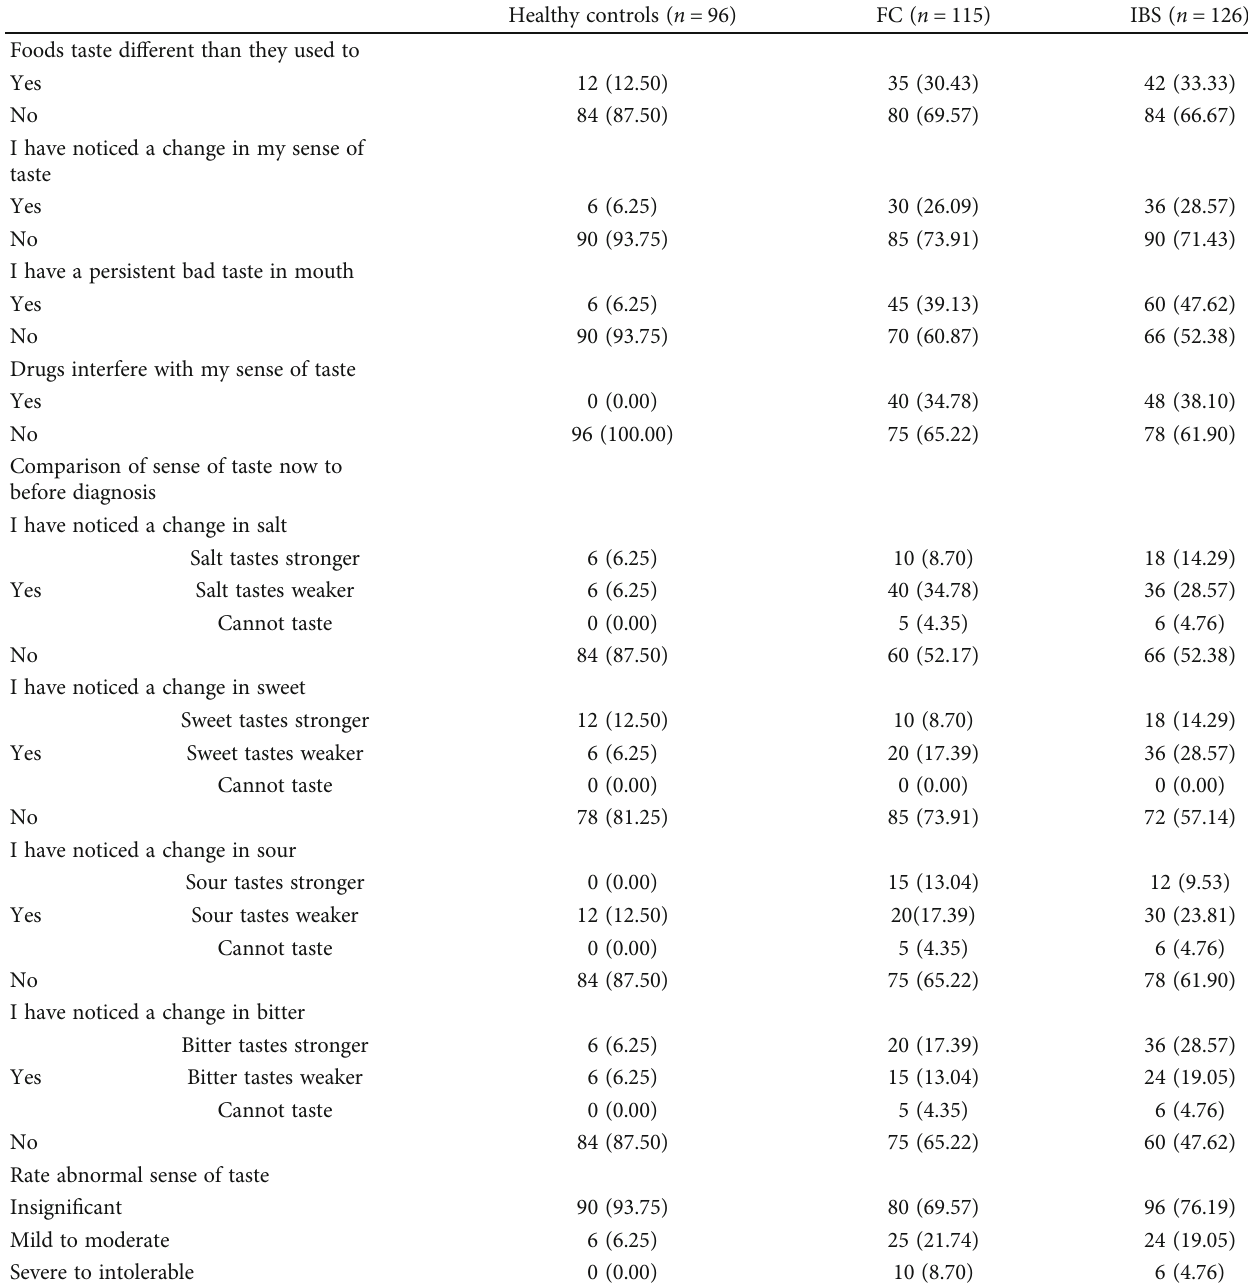
Table 4: Breakdown of the detailed taste complaints from the taste and smell survey. Healthy controls ( n = 96